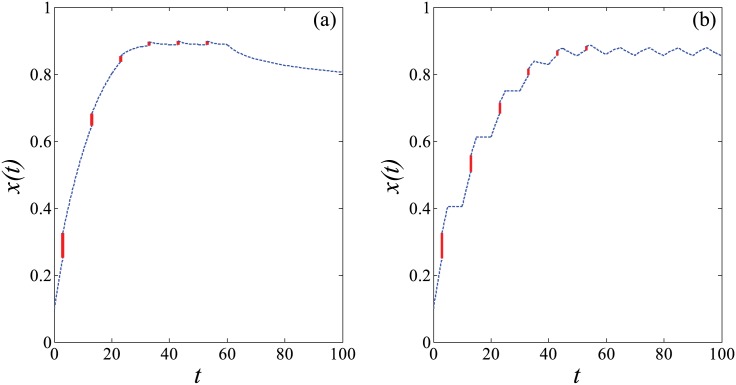
(Color online) Variation of X with t in periodic impulsive system.We set parameters to η1 = 0.6, η2 = 0.6, α = 0.9, β = 3, C = 10, k = 106, x(0) = 0.1, with one impulse effect (E1 = 0.1) at only one fixed moment (t1 = 3) per period (T = 10) for six periods (N = 6) in Eq (5). (a) s(t) follows Eq (2), Tm = 60; (b) s(t) follows Eq (3), Tm = 5. The blue dotted curves display the growth of knowledge stock in self-regulated learning over time. While the red solid lines show the rapidly increasing amount of knowledge within a short time after the teacher guidance.